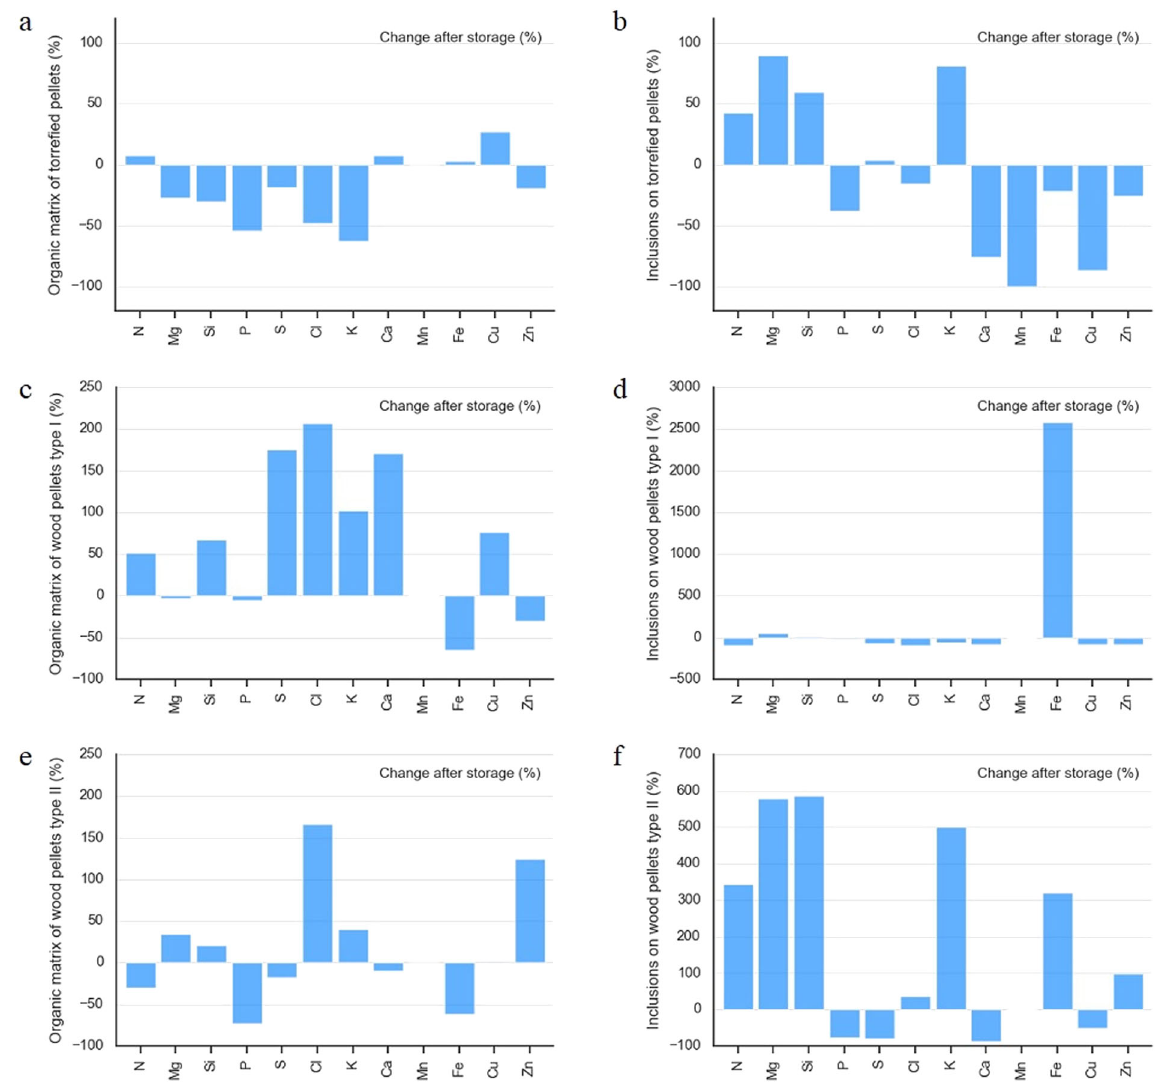
Fig. 6 Percentage change of mean elemental concentrations of the matrix and surface inclusions of biomass pellets after 1 month of storage. a Organic matrix of torre fi ed pellets. b Inclusions on torre fi ed pellets. c Organic matrix of wood pellet types I. d Inclusions on wood pellets type I. e Organic matrix of wood pellet type II. f Inclusions on wood pellets type II. Light blue bars represent the mean elemental concentration of each element detected at the surface of the